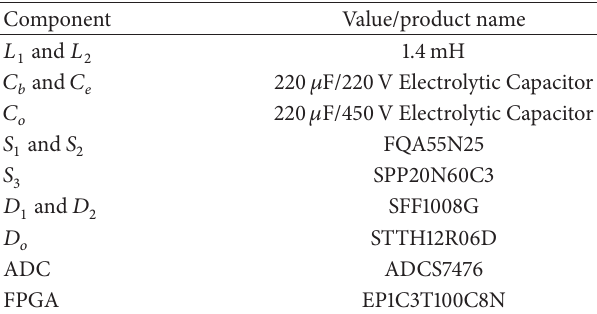
Table 3: Component